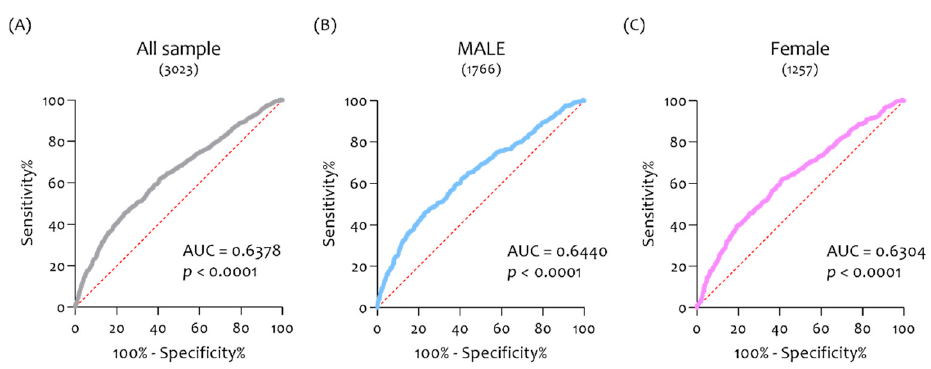
Figure 8. CHID1 brain expression levels as a prognostic marker of AD. In order to evaluate the potential diagnostic ability of CHID1 to discriminate against the AD patients from NDHC subjects, we performed a receiver operating characteristic (ROC) analysis. CHID1 expressed fair diagnostic ability (AUC = 0.6368, p < 0.0001) ( A ). This ability was maintained for both males (AUC = 0.6440, p < 0.0001) ( B ) and females (AUC = 0.6304, p < 0.0001) ( C ).